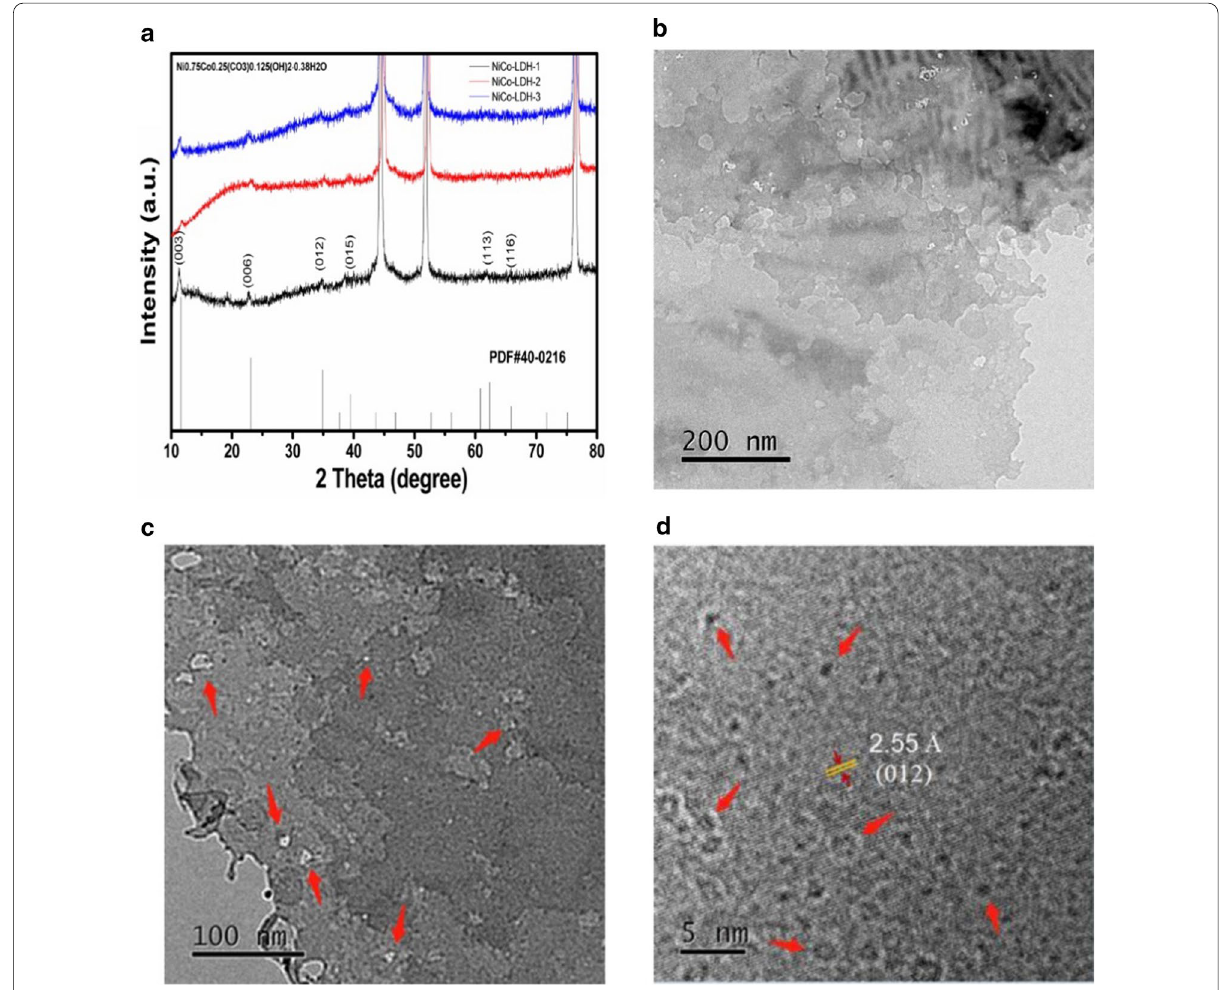
Fig. 2 a X-ray diffraction patterns of the samples; b – d TEM images of NiCo-LDH-1